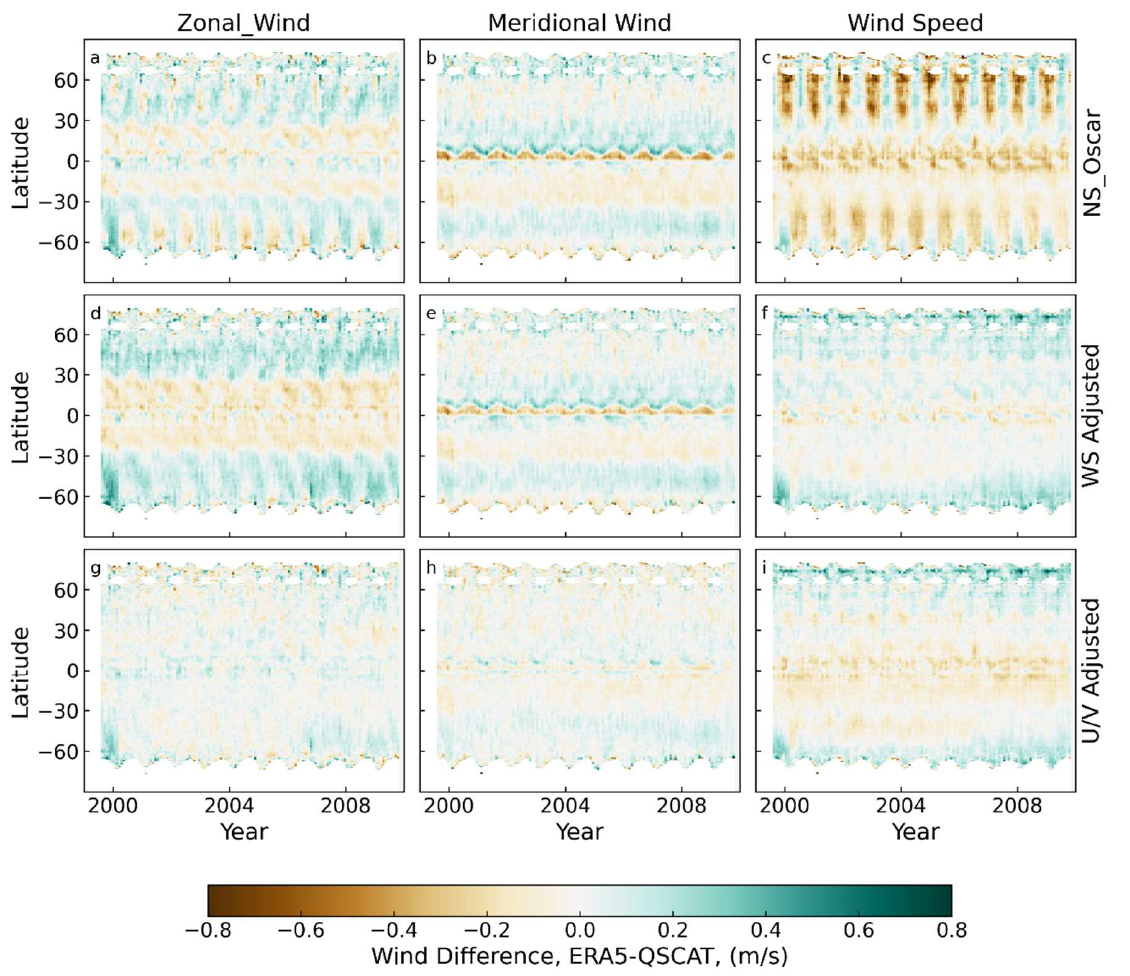
Figure 7. Hovmöller diagrams of ERA5—QuikSCAT wind differences for 2000–2009. Panels ( a – c ) show the differences for zonal wind, meridional wind, and wind speed when only the ocean adjust- ments for currents are applied to ERA5. Panels ( d – f ) show the same differences after the wind speed adjustment was applied. Panels ( g – i ) shown the final results after the regional vector-component biases are also removed. Results for ERA5—ASCAT-A are similar (see Figure A3).